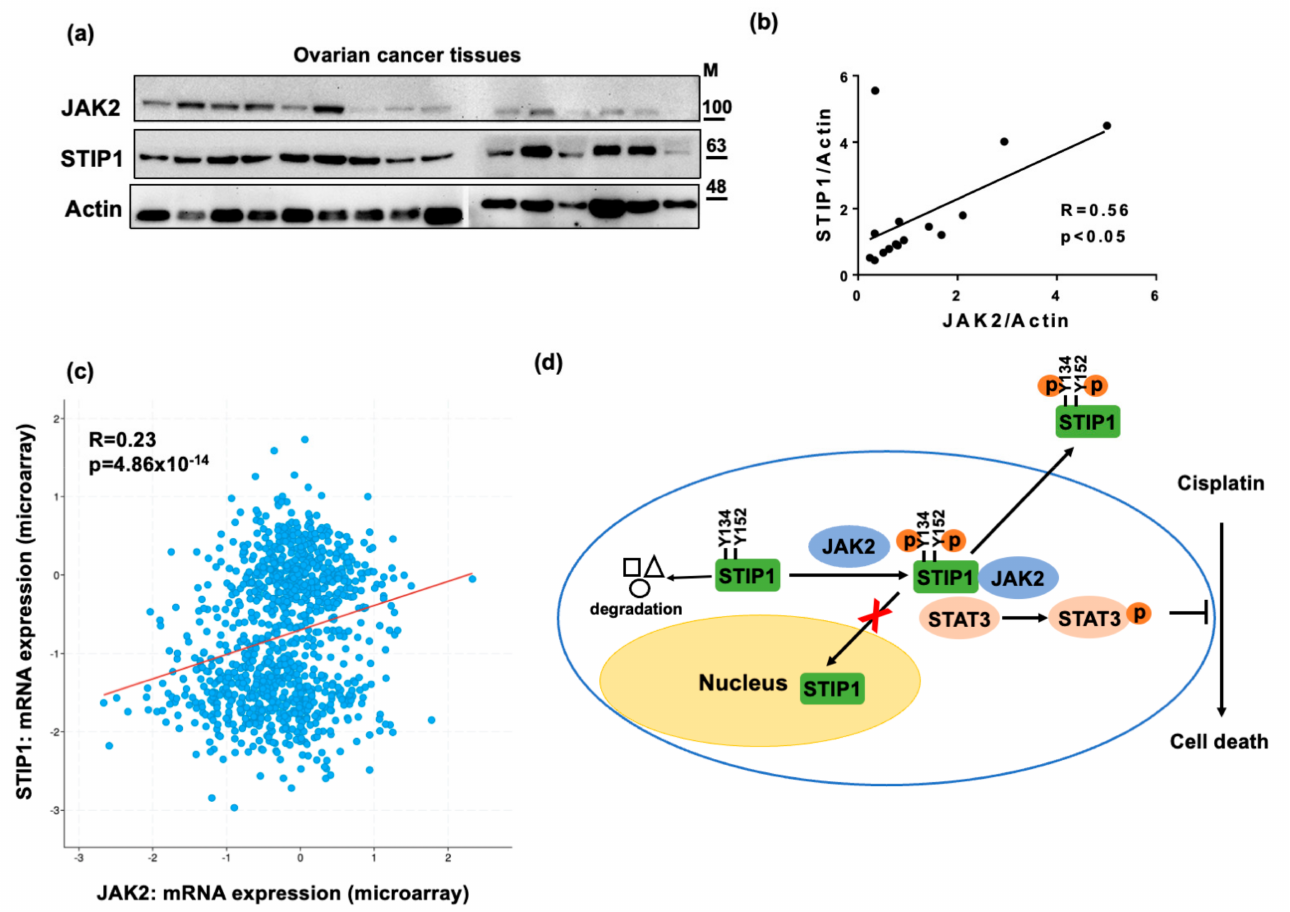
Figure 7. JAK2 and STIP1 protein expression levels are positively correlated to each other in human ovarian cancer tissue specimens. ( a ) JAK2 and STIP1 protein levels were determined by western blot in 15 serous ovarian cancer samples. Actin levels served as loading control. ( b ) Correlation between JAK2 and STIP1 protein levels in ( a ) after normalization to the corresponding actin intensity. ( c ) The correlation between JAK2 and STIP1 mRNA expression levels was investigated using data from Cancer Genome Atlas (TCGA) for ovarian cancer. ( d ) Key findings from this study: STIP1 phosphorylation—mediated by JAK2—promotes STIP1 stability, maintains the JAK2-STAT3 signaling pathway, is resistant to cisplatin treatment, and regulates STIP1 nuclear-cytoplasmic shuttling and its secretion in the extracellular